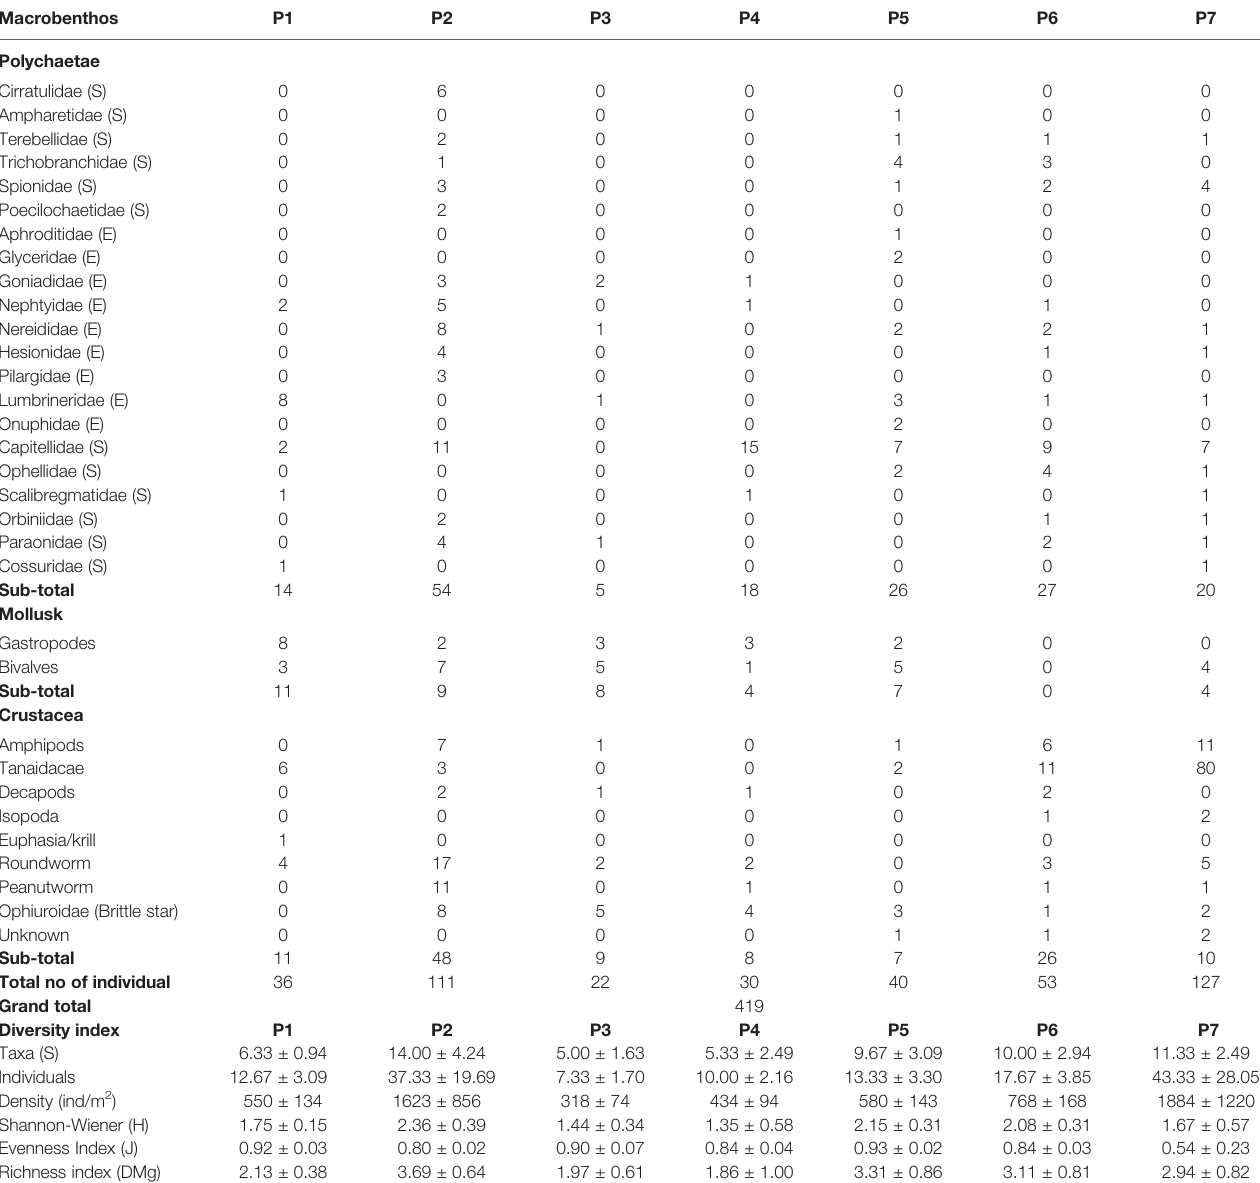
TABLE 5 | Summary of the biological parameters of the macrobenthos communities: mean number of taxa, individuals and Shannon Diversity Index Macrobenthos